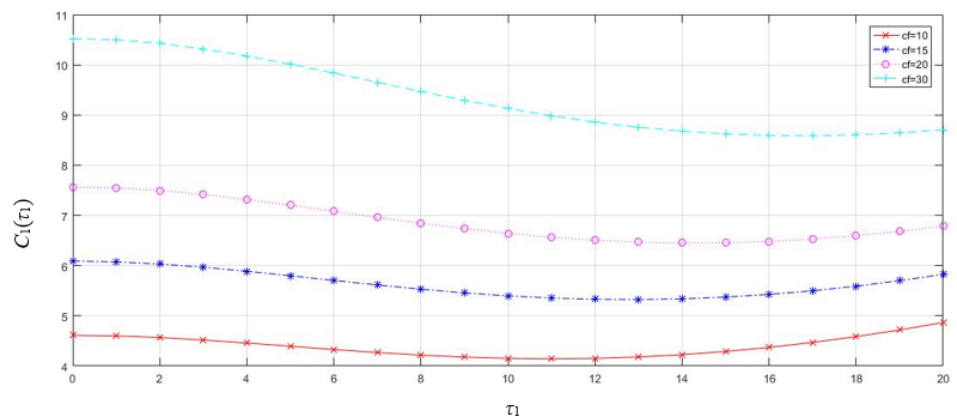
τ Figure 5. The plot of C 1 ( τ 1 ) for different values of c f . Figure 5. The plot of 1 1 ( ) C for different values of c f.